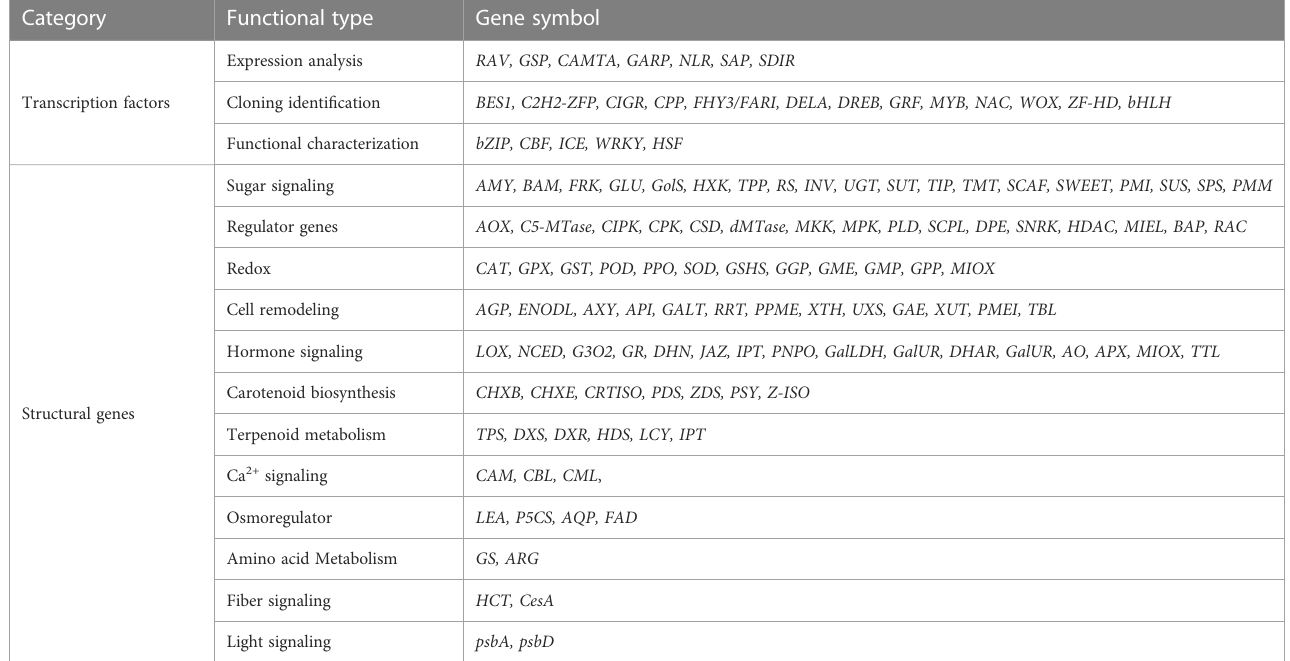
TABLE 1 List of the genes/gene families involved in cold tolerance of tea plant.